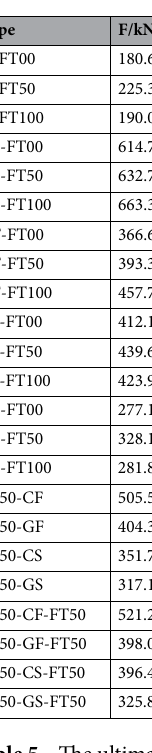
Table 5. The ultimate stress and strain. ε ′ cc is the axial strain at the peak point of the ordinary FRP confined concrete; ε ′ h is the lateral strain at the peak point of the ordinary FRP confined concrete; ε ′ co is the axial strain at the peak point of the unconfined concrete. f ′ cc is the axial stress at the peak point of the ordinary FRP confined concrete; f ′ co is the axial stress at the peak point of the unconfined concrete.